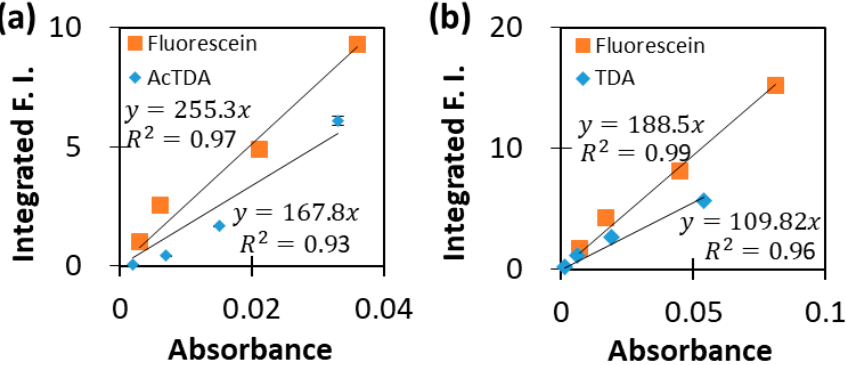
Figure 6. Gradient plot of integrated fluorescence intensity against absorbance for ( a ) AcTDA and fluorescein and ( b ) TDA and fluorescein.